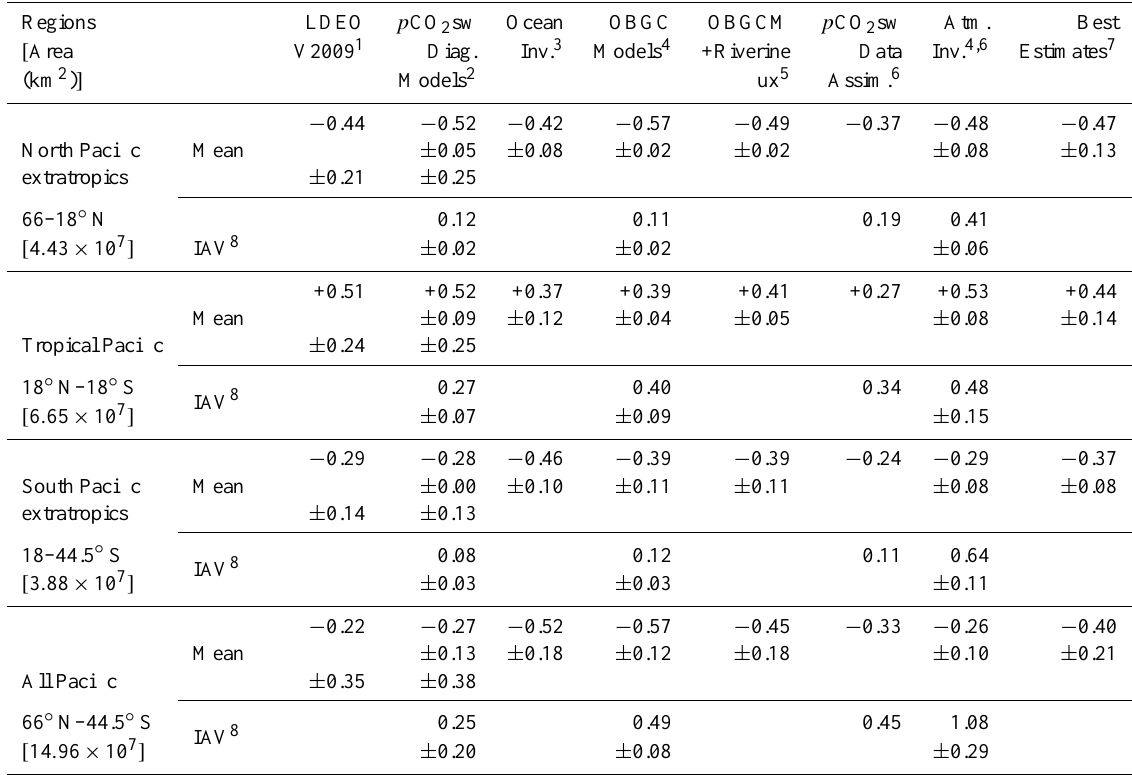
Table 4. Mean and amplitude of interannual variability (IAV) of regionally integrated air–sea CO 2 flux in the sub-basins of the Pacific Ocean for the period 1990–2009. All units arePgCyr − 1